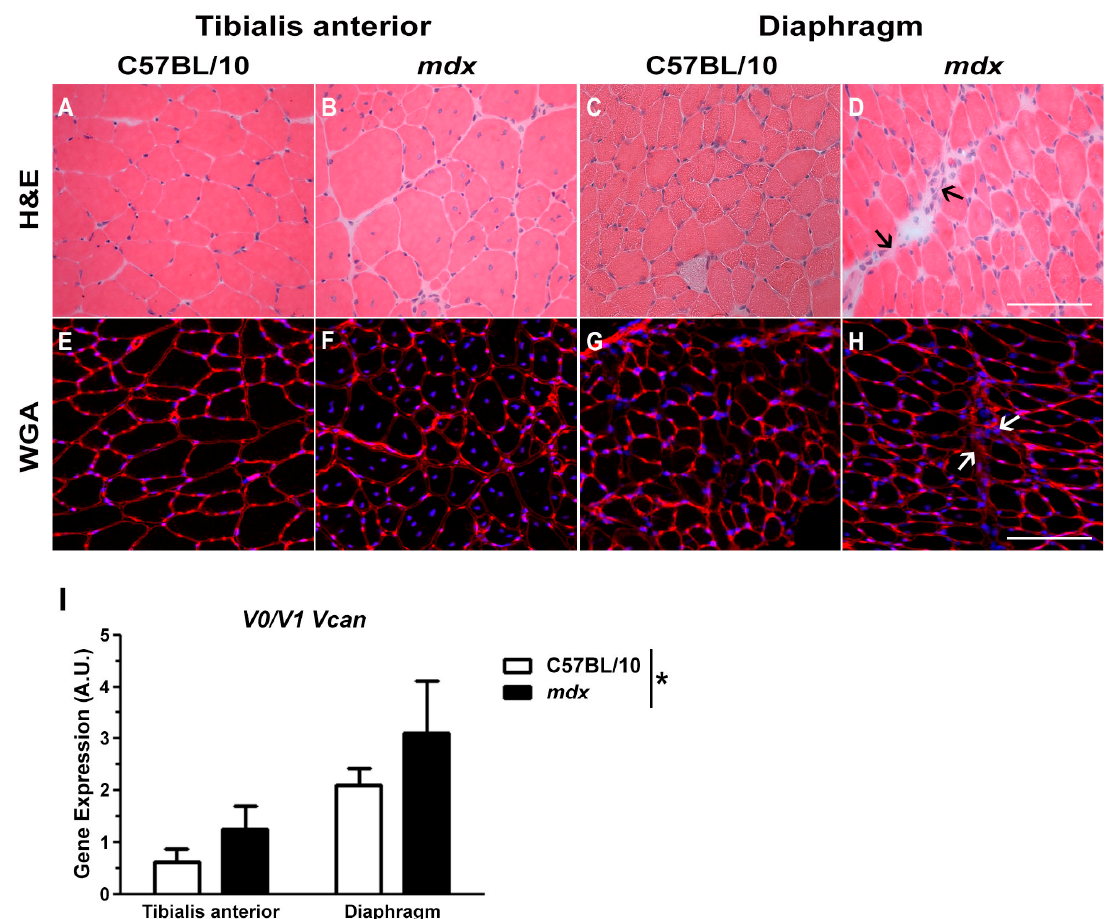
Figure 1. Muscle architecture and fibrosis in wild type and mdx mice. ( A – D ) Muscle architecture can be determined from the H and E-stained muscle cross-sections, and ( E – H ) areas of fibrosis can be observed by examining wheat germ agglutinin (WGA) stained cross-sections. ( I ) Versican ( V0/V1 Vcan ) mRNA transcript abundance was increased in mdx compared to wild type mice (* p = 0.026; main effect genotype; 2-way general linear model (GLM) ANOVA). Arrows denote areas of fibrosis and mononuclear infiltrate. Gene expression analysis was determined from n = 3 wild type mice and n = 3 mdx mice. Scale bar = 100 µm. Error bars = S.E.